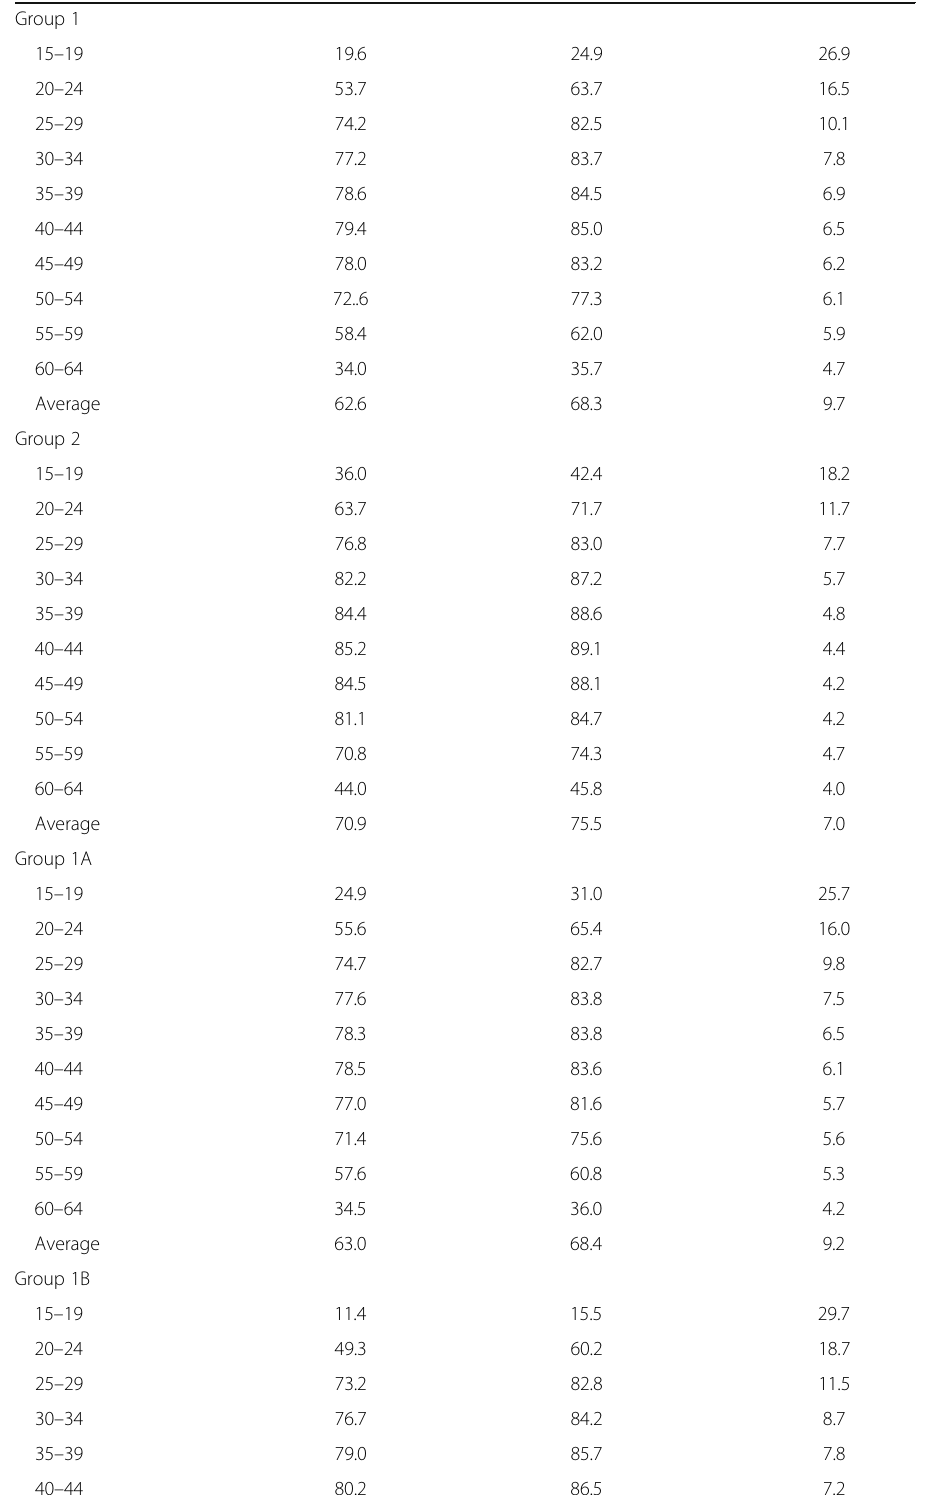
Table 5 Labor market performance variables, averages per group of countries and age category, 2000 – 2014 Groups and age